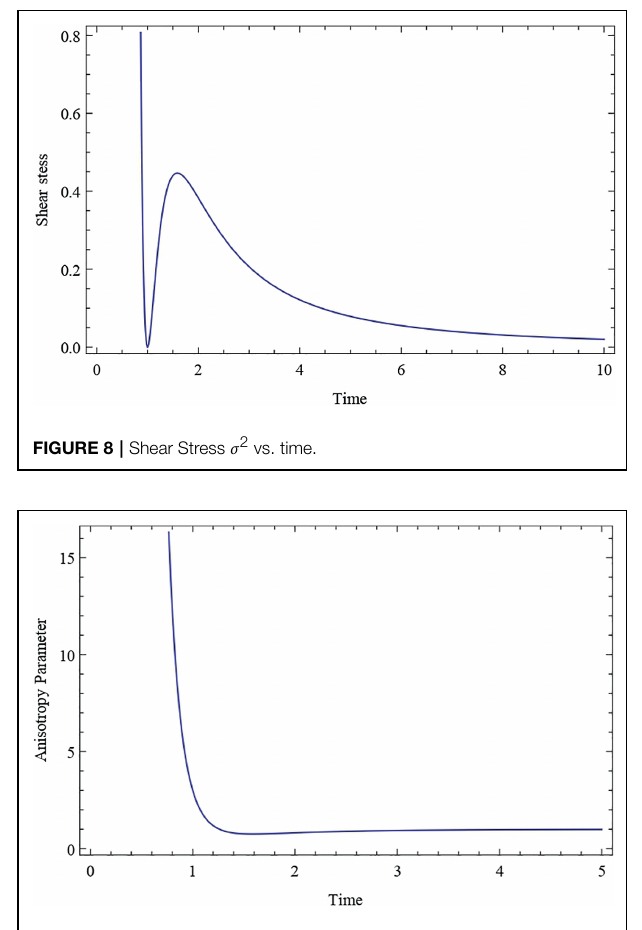
FIGURE 9 | Anisotropy Parameter △ vs.